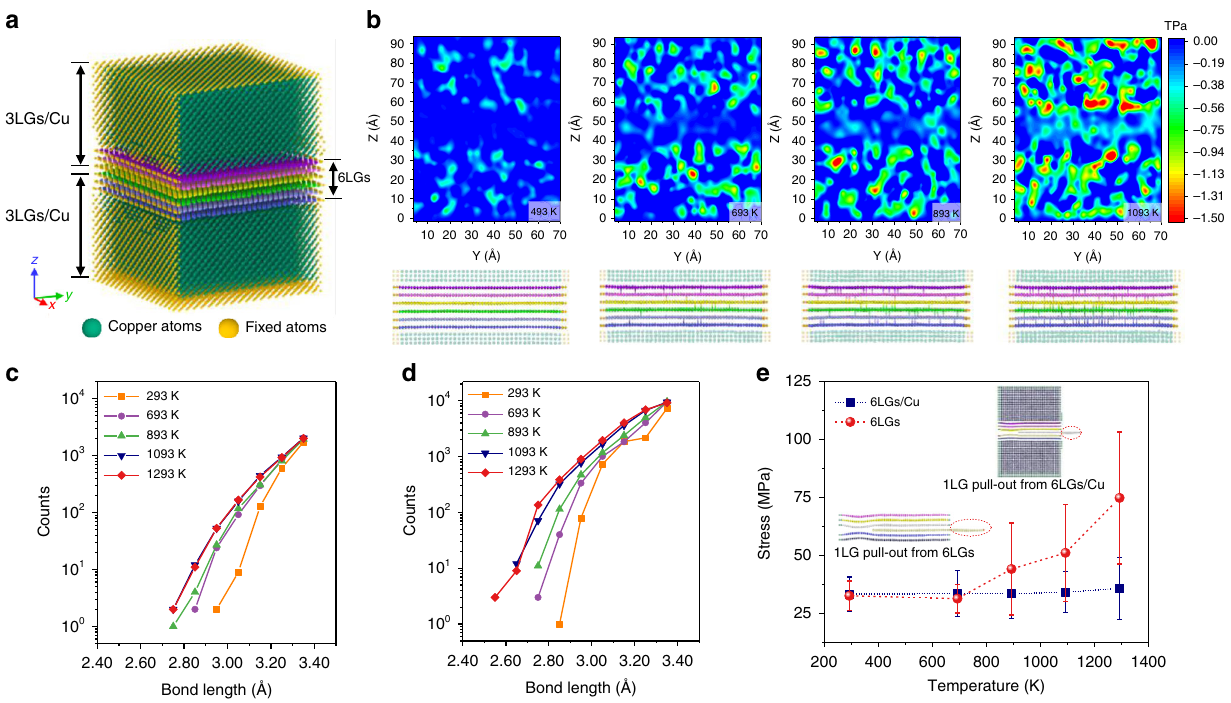
Fig. 4 MD simulations of welding between graphene-like nanosheets. a Atomic con fi guration of two face-to-face contact 3LGs/Cu (6LGs/Cu). b Simulation results illustrating the color Z-direction stress maps of Y – Z single-layer slice in the middle of 6LGs/Cu and the formation of covalent-like bonds between graphene layers at 493 K, 693 K, 897 K, and 1093 K. c , d The bonding length statistics at different simulated temperatures of ( c ) 6LGs and ( d ) 6LGs/Cu models. e The 1LG pull-out stress versus temperature plots for 6LGs and 6LGs/Cu. Source data are provided as a Source data fi